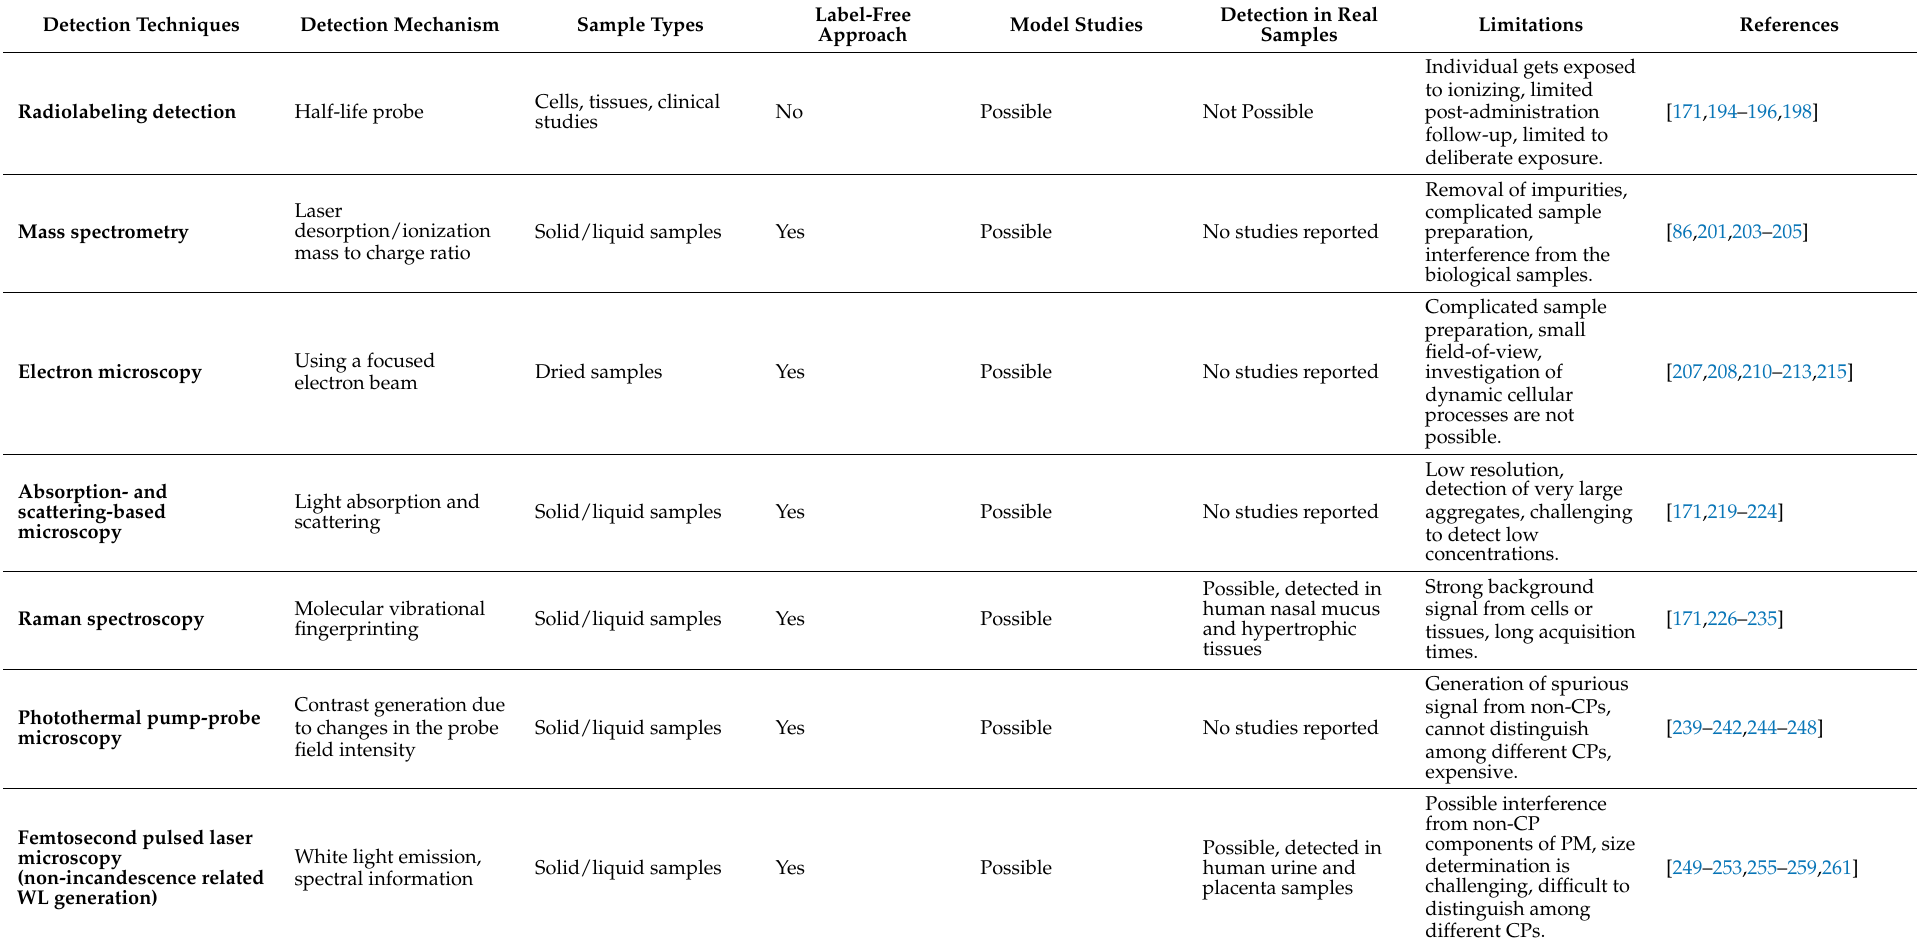
Table 2. Techniques for detection of CPs in biological